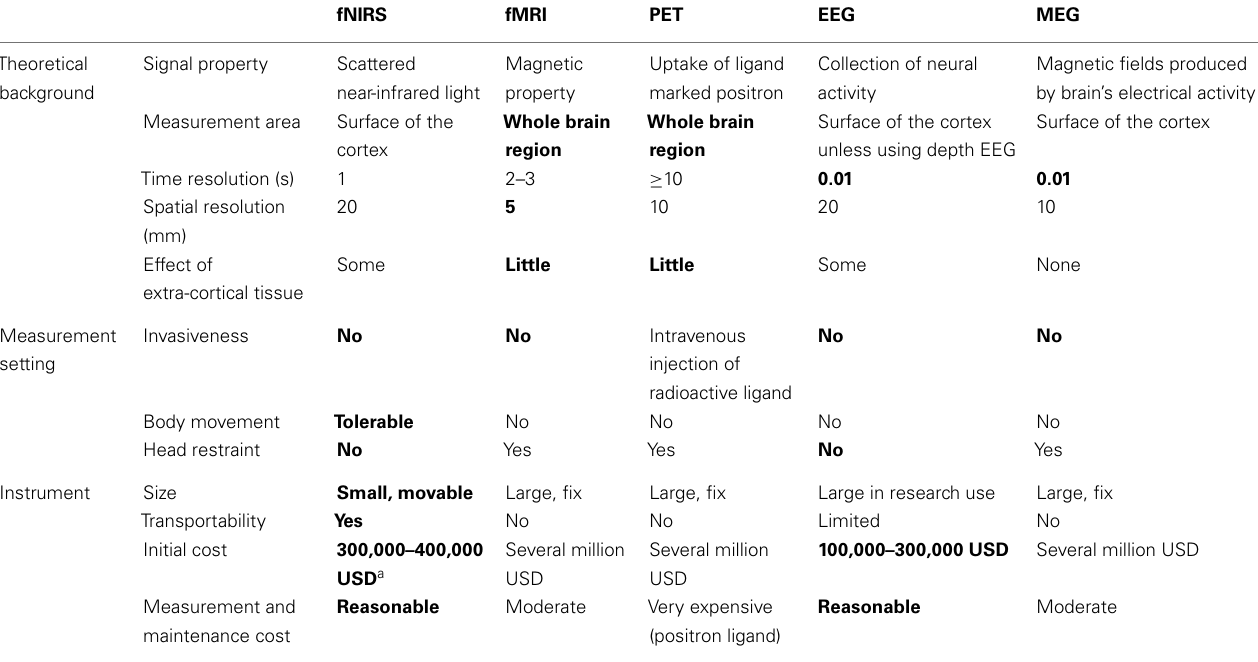
Table 1 | Comparison of CW-type fNIRS machines with other neuroimaging